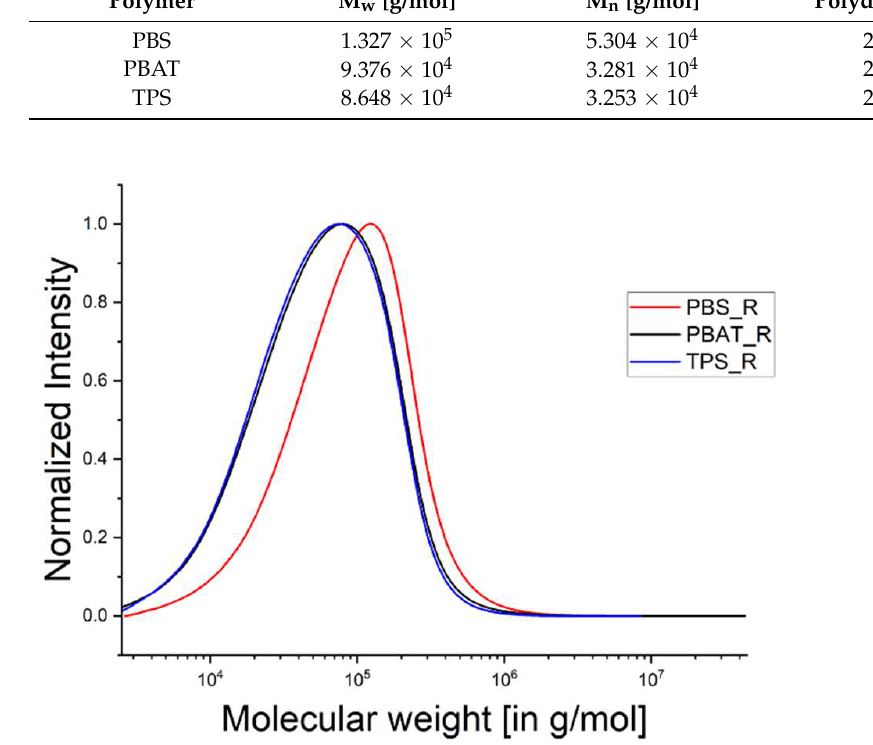
Figure 4. GPC elugrams after rheological measurement representing the biopolymers PBS, PBAT and TPS.